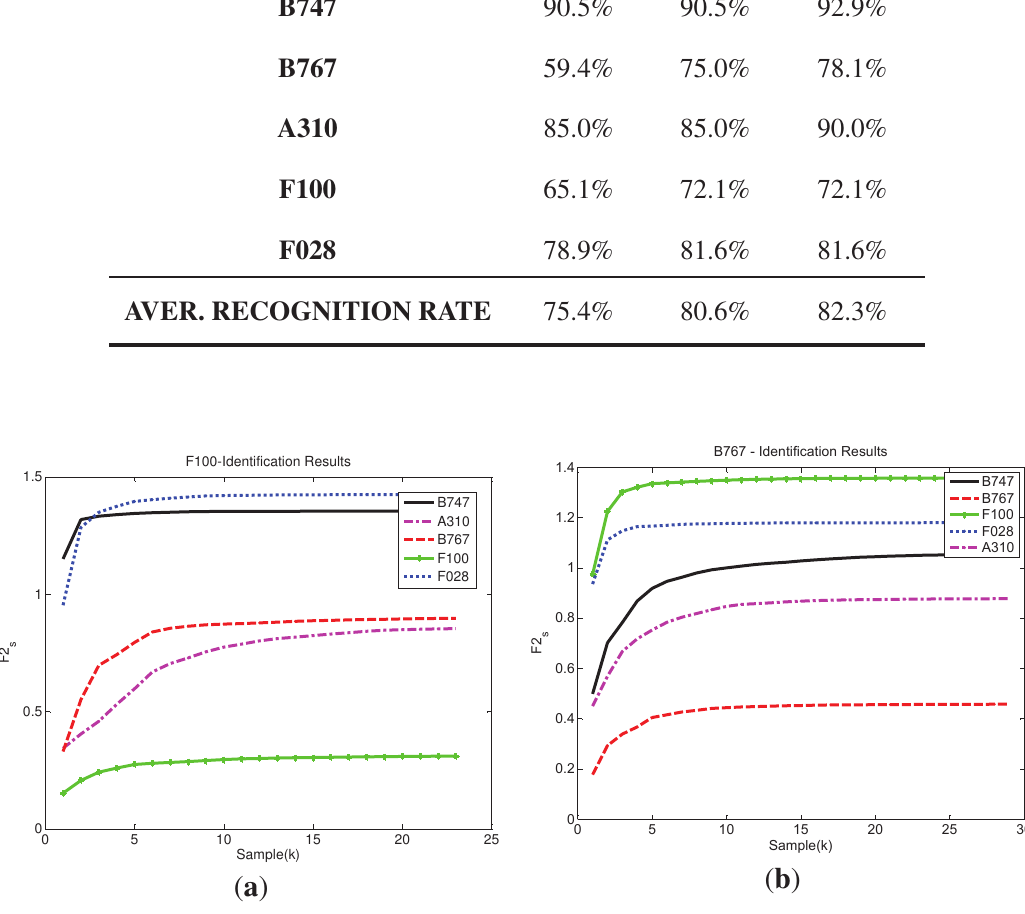
Figure 6. Example of identification results for two different aircraft in two different trajectories with a threshold of η = 0 . 85